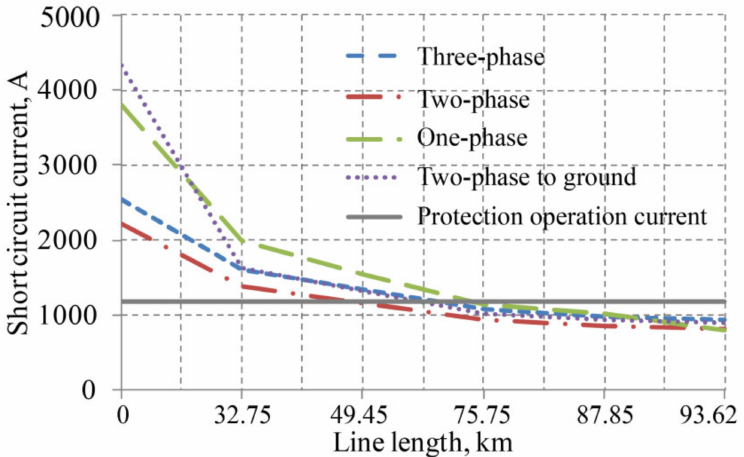
Figure 17. Change in the “dead zone” length for the soil resistance of 1000 Ohm · m, the setpoint was calculated according to the traditional OHL technique.